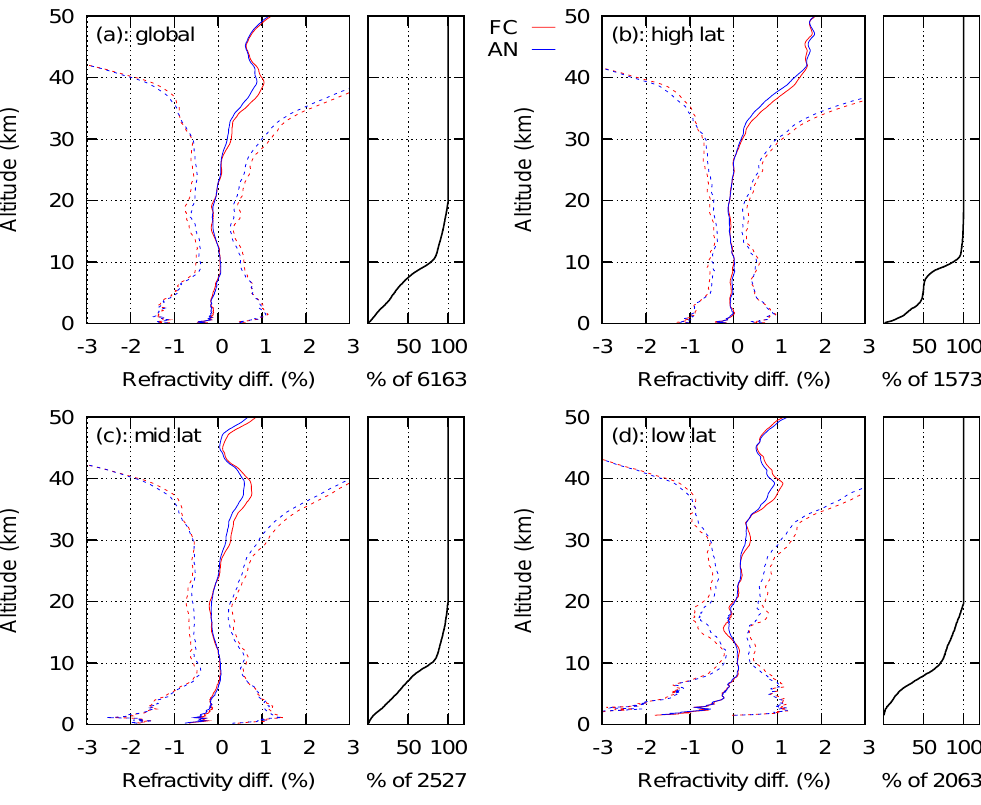
Fig. 3. Statistical comparisons to ECMWF analyses (blue) and short-range forecasts (red) of refractivity derived from GRAS occultations for the first 10 days of December 2010. (a) Global, (b) high latitudes (above 60 ◦ ), (c) mid latitudes (between 30 ◦ and 60 ◦ ), (d) low latitudes (below 30 ◦ ). The mean difference (solid) and standard deviation around the mean (dashed) are indicated in the panels to the left, whereas the number of profiles included in the statistics is indicated in the panels to the right.